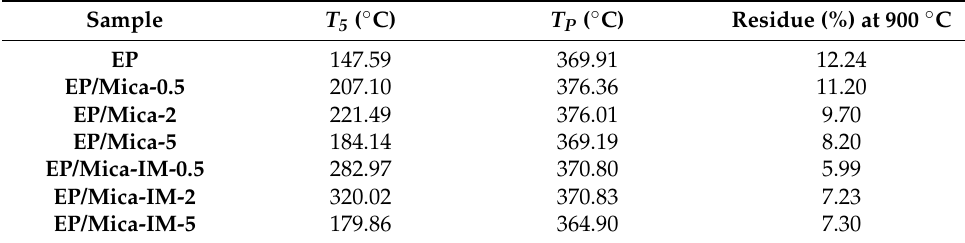
Figure 12. TGA ( a ) and DTG ( b ) thermograms of studied samples. Table 5. Parameters of TGA test for the studied